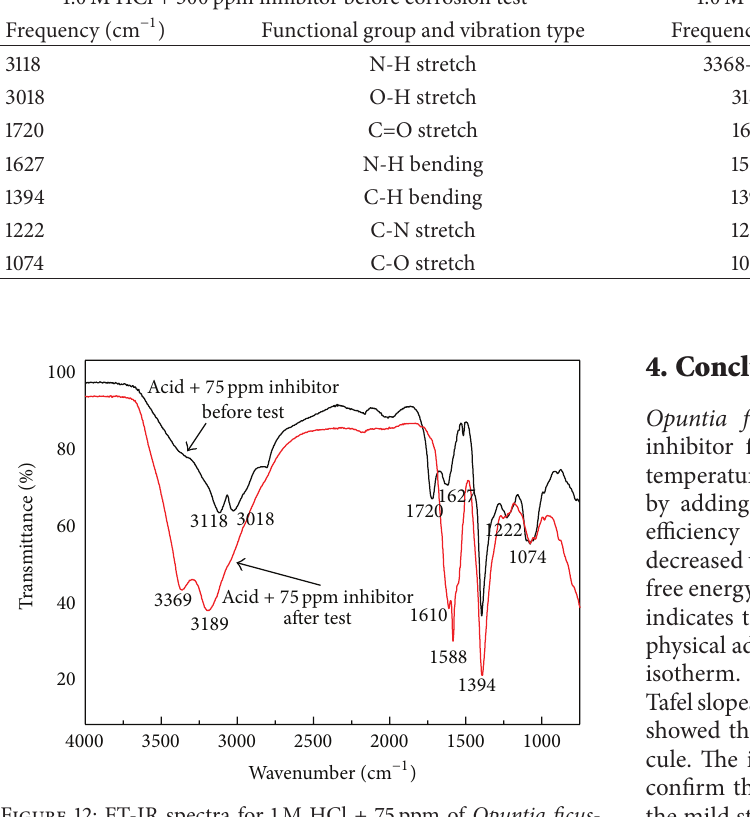
Figure 12: FT-IR spectra for 1M HCl + 75 ppm of Opuntia ficus- indica extract before and after corrosion